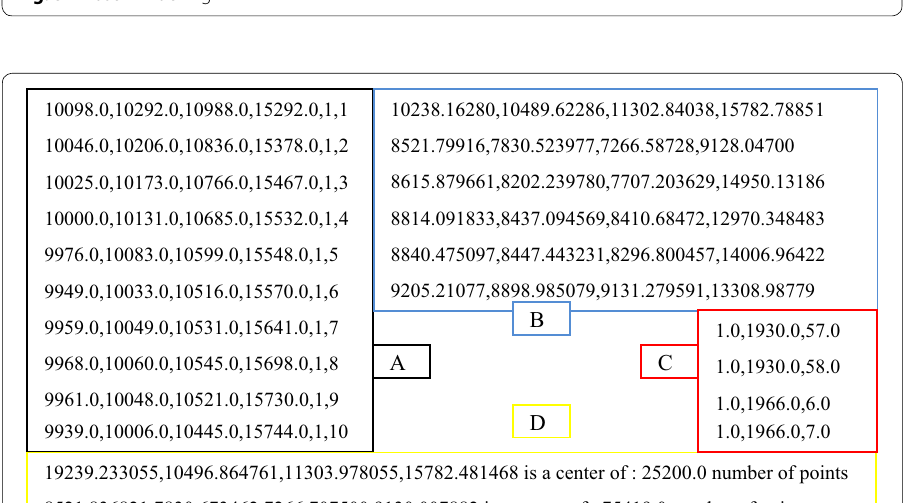
Fig. 3 Phase-1 indexing